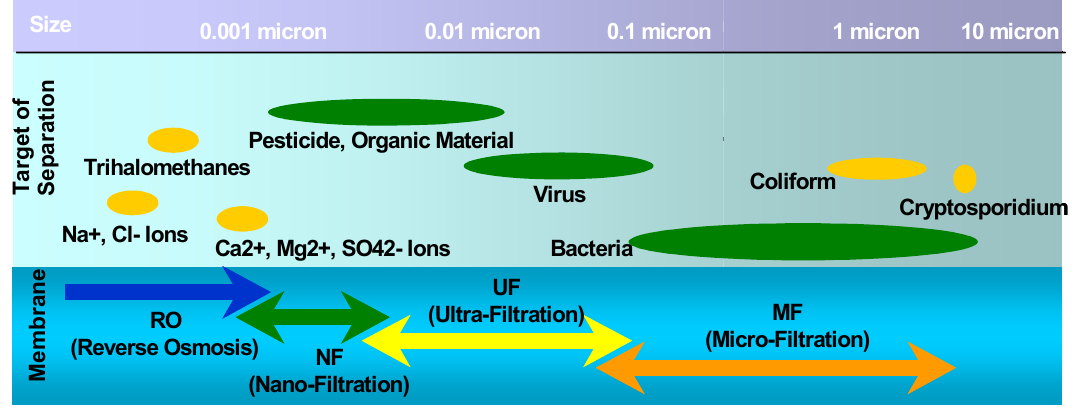
Figure 1. Membrane processes and filtration ranges.